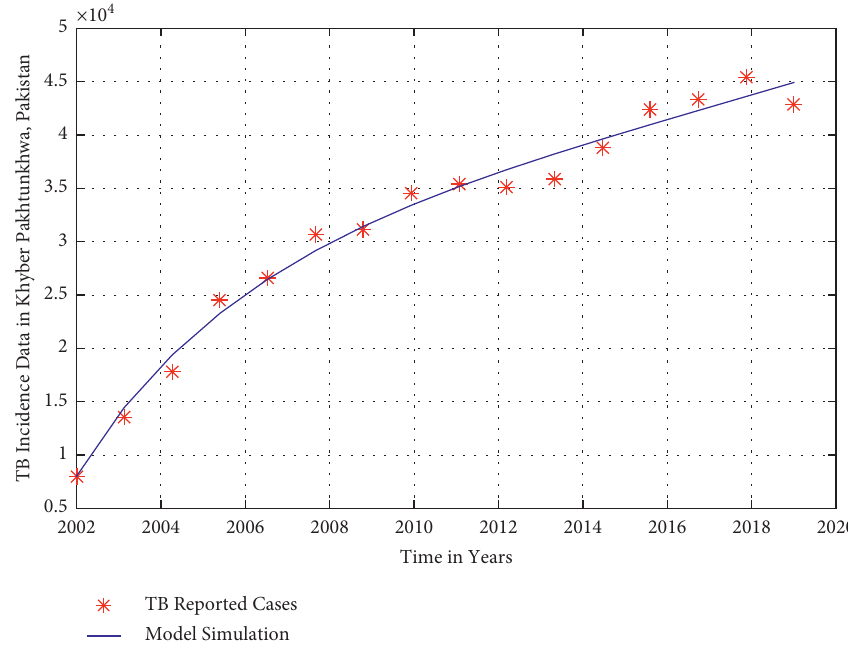
Figure 1: Model fitting (solid blue line) to the TB reported cases (red) from 2002 to